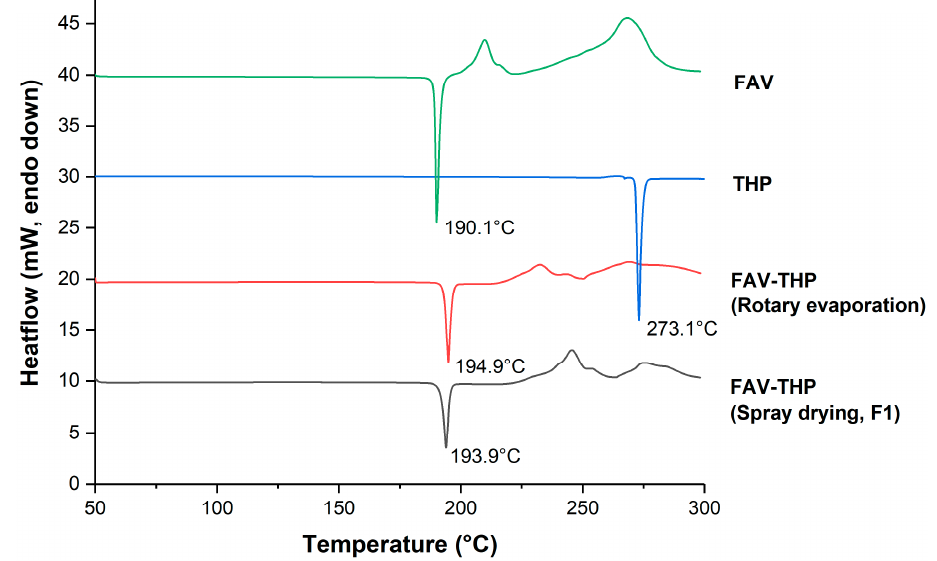
Figure 3. Overlaid DSC thermograms of the FAV-THP cocrystal system.